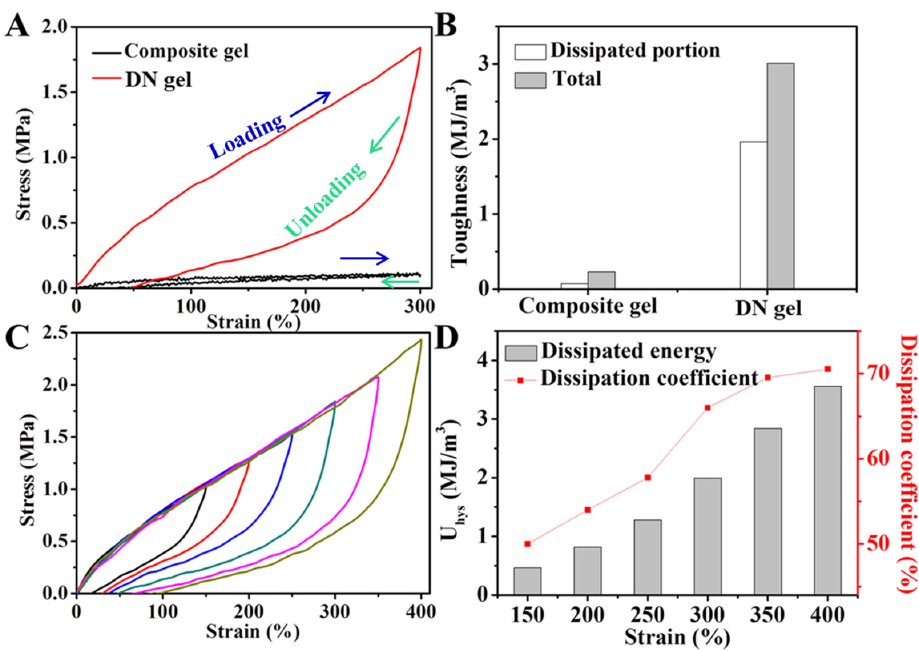
Figure 3. ( A ) Loading–unloading curves of composite and DN hydrogels at a strain of 300% and ( B ) their corresponding calculated dissipated energy and energy-dissipation coefficient. ( C ) Loading–unloading curves of DN hydrogel at different strains (150%, 200%, 250%, 300%, 350%, and 400%) and ( D ) corresponding calculated dissipated energy and energy-dissipation coefficient.